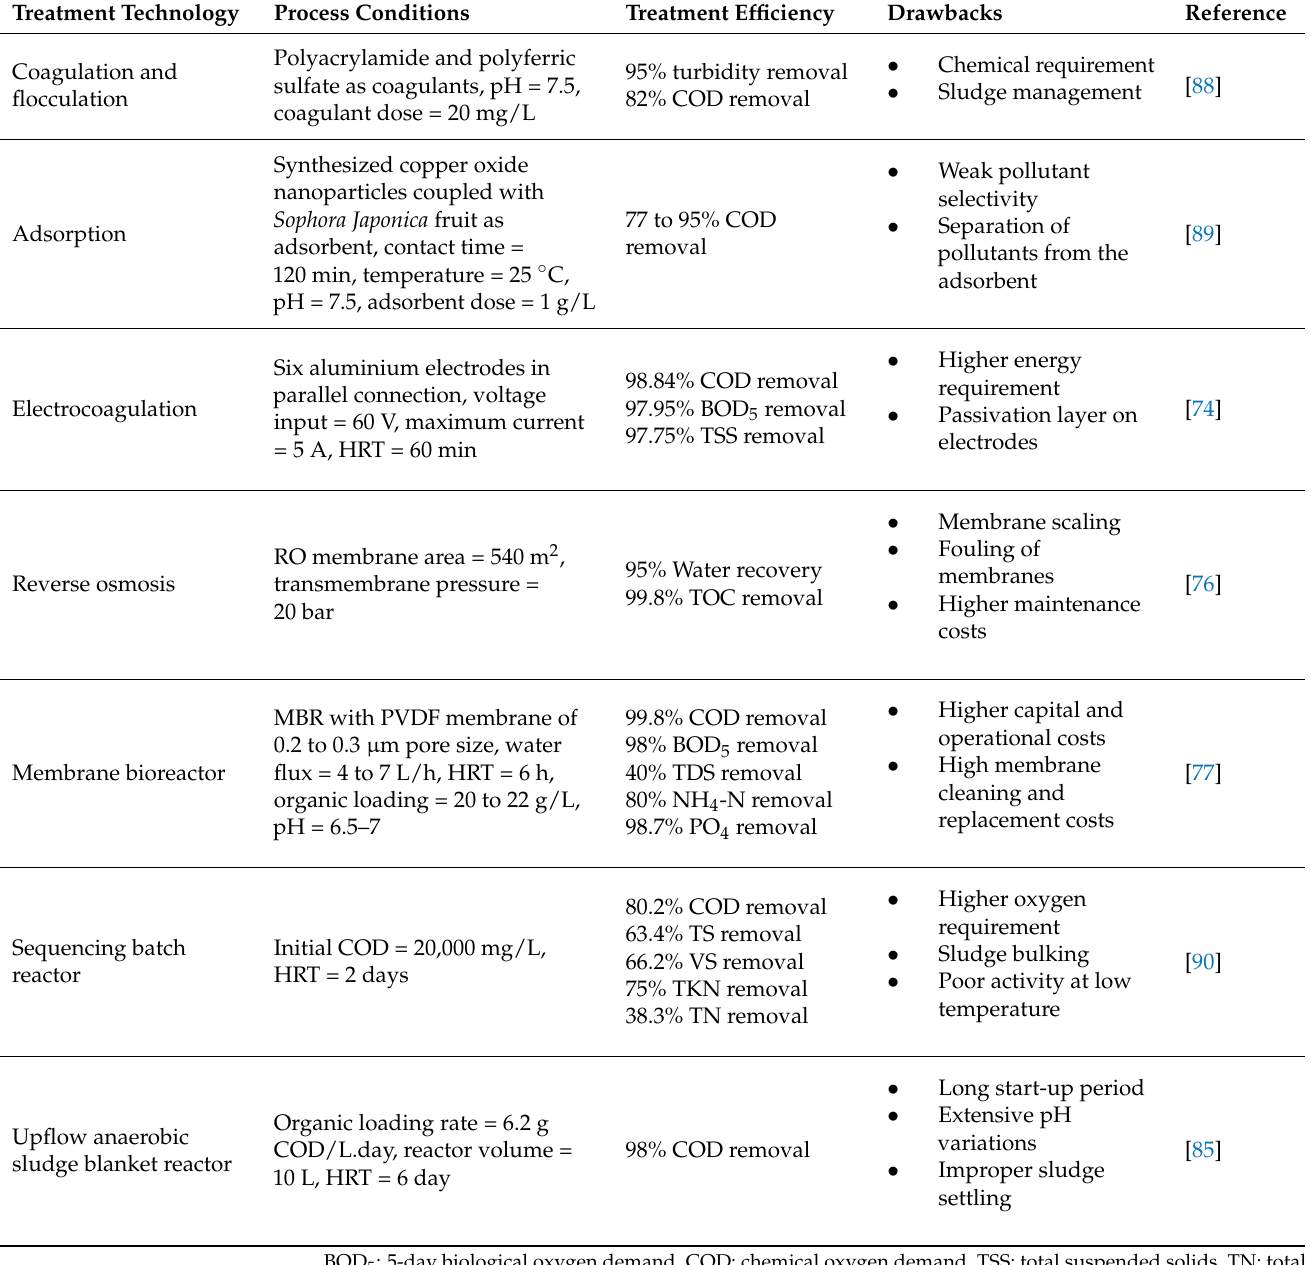
Table 3. Treatment of dairy wastewater using different treatment